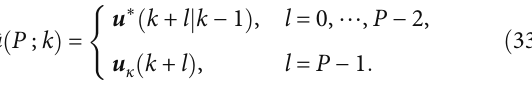
Figure 7: Implementation of the guidance approach with obstacle